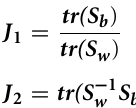
PSD of each frequency bin of each segment is divided by the total PSD of each segment. (C) The frequency-domain feature extraction based on the manual scoring